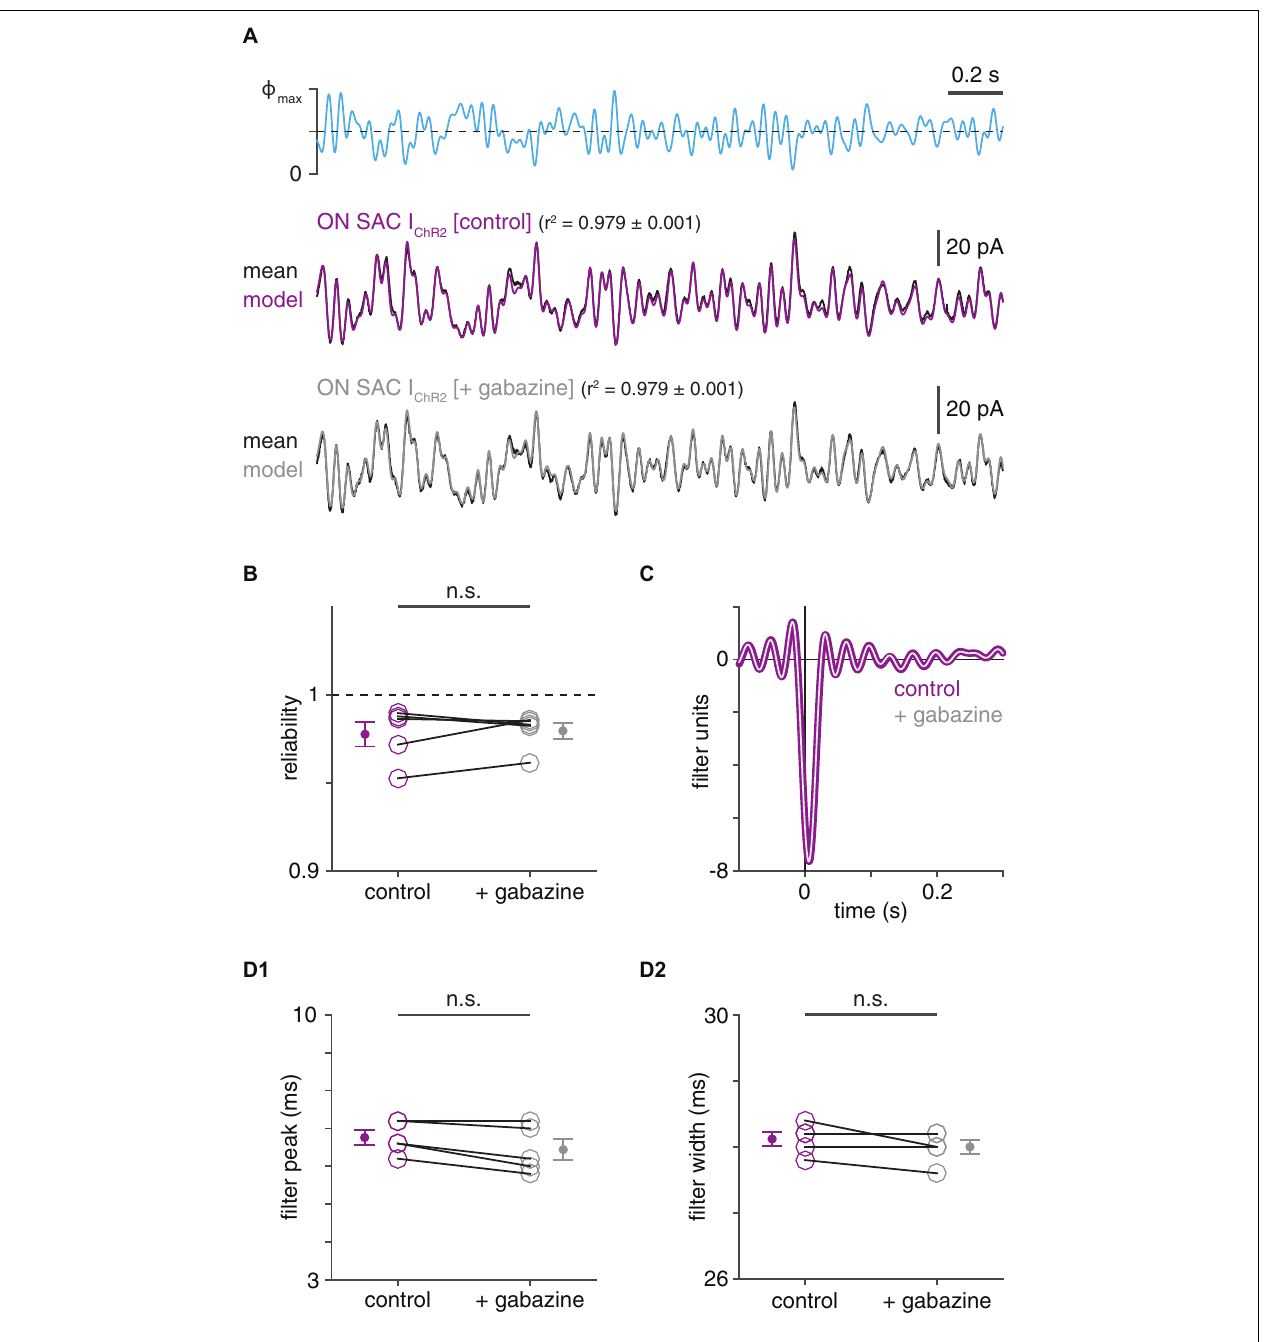
FIGURE 3 | Effective isolation of ChR2- from GABA A R-mediated currents in ON SACs using voltage clamp. (A) ChR2-mediated inward currents recorded in a ChR2 + ON SAC before and after GABA A R blockade. Top , optogenetic white-noise stimulus ( (cid:56) max = 4.8 × 10 17 Q cm − 2 s − 1 ). ChR2-mediated inward currents before ( middle ) and after ( bottom ) bath application of gabazine (50 µ M). (B) Inter-trial reliability of ChR2-mediated currents in ON SACs ( n = 5) before and after gabazine application. (C) Linear filters obtained from ChR2-mediated currents in ON SAC shown in (A) before (thick purple trace) and after (thin gray trace) gabazine application. (D) Peak times (D1) and widths (D2) of linear filters obtained from LN analysis of ChR2-mediated currents in ON SACs before and after gabazine application. n.s., not significant.